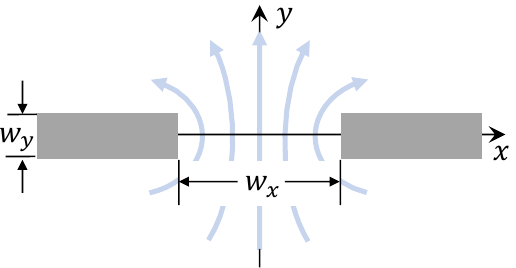
Figure 1: Cartoon of current flow through a constriction; the widths w depicted. Region O is unshaded; region I (the constriction) is shaded gray. We